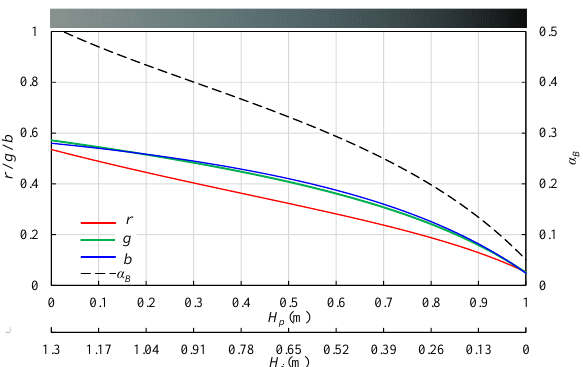
Figure 8. Variations of the RGB intensities of pond color and melt- pond albedo during the process of sea-ice melting, assuming H i + δH p = 1.3m. The color bar on the top denotes the simulated color of the melt pond during ice